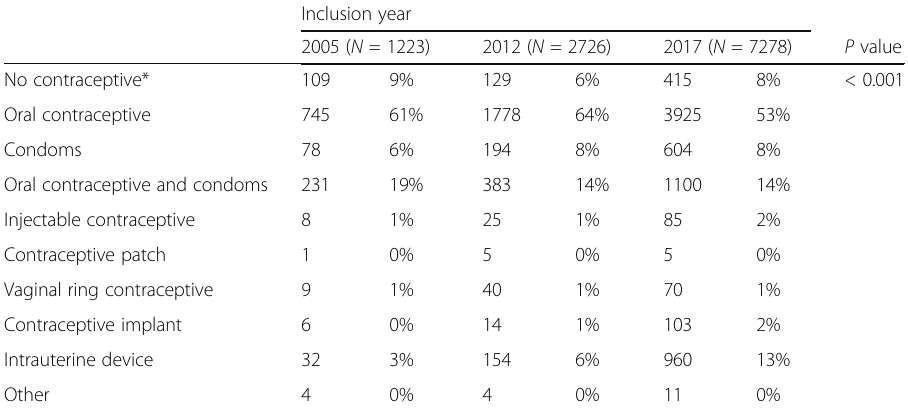
Table 2 Contraception used by Dutch girls aged 12 to 25 years who experienced at least